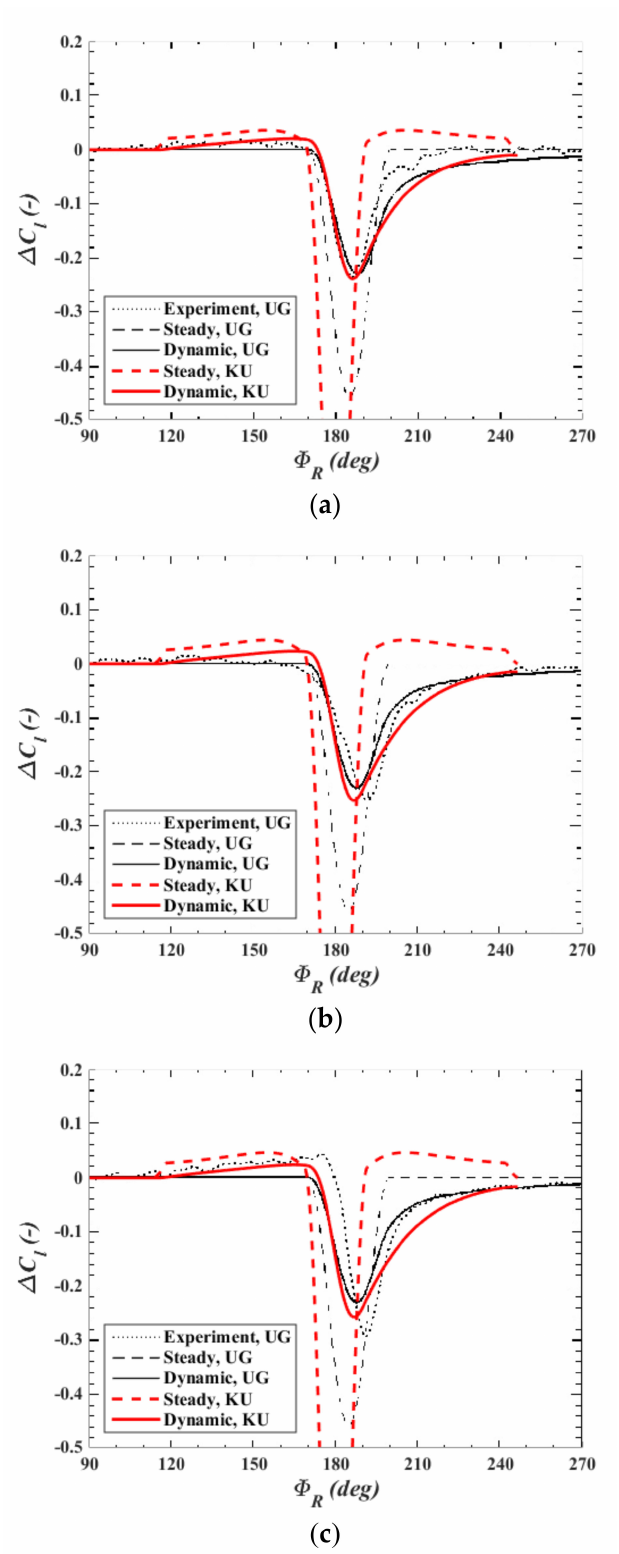
Figure 12. Deviations in the lift coe ffi cient at η B = 75% according to 0.5% of the dead band, C d = 1.2 [24]: ( a ) Case 1: V T = 36.0 m / s; ( b ) Case 2: V T = 44.1 m / s; ( c ) Case 3: V T = 46.7 m /